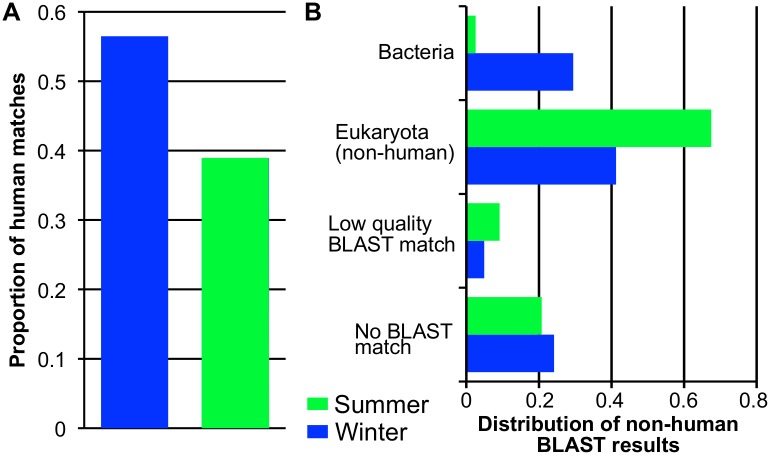
Differences in the abundance of organisms identified on $1 bills collected in Winter vs. Summer 2013.(A) Proportion of human matches identified by megaBLAST-LCA for each time point. (B) Proportional distribution of non-human megaBLAST-LCA results. Low quality matches are defined as those filtered out prior to LCA analysis (see Materials and methods). High quality BLAST matches are broken down by taxonomic category and only categories with proportions >1% are included.